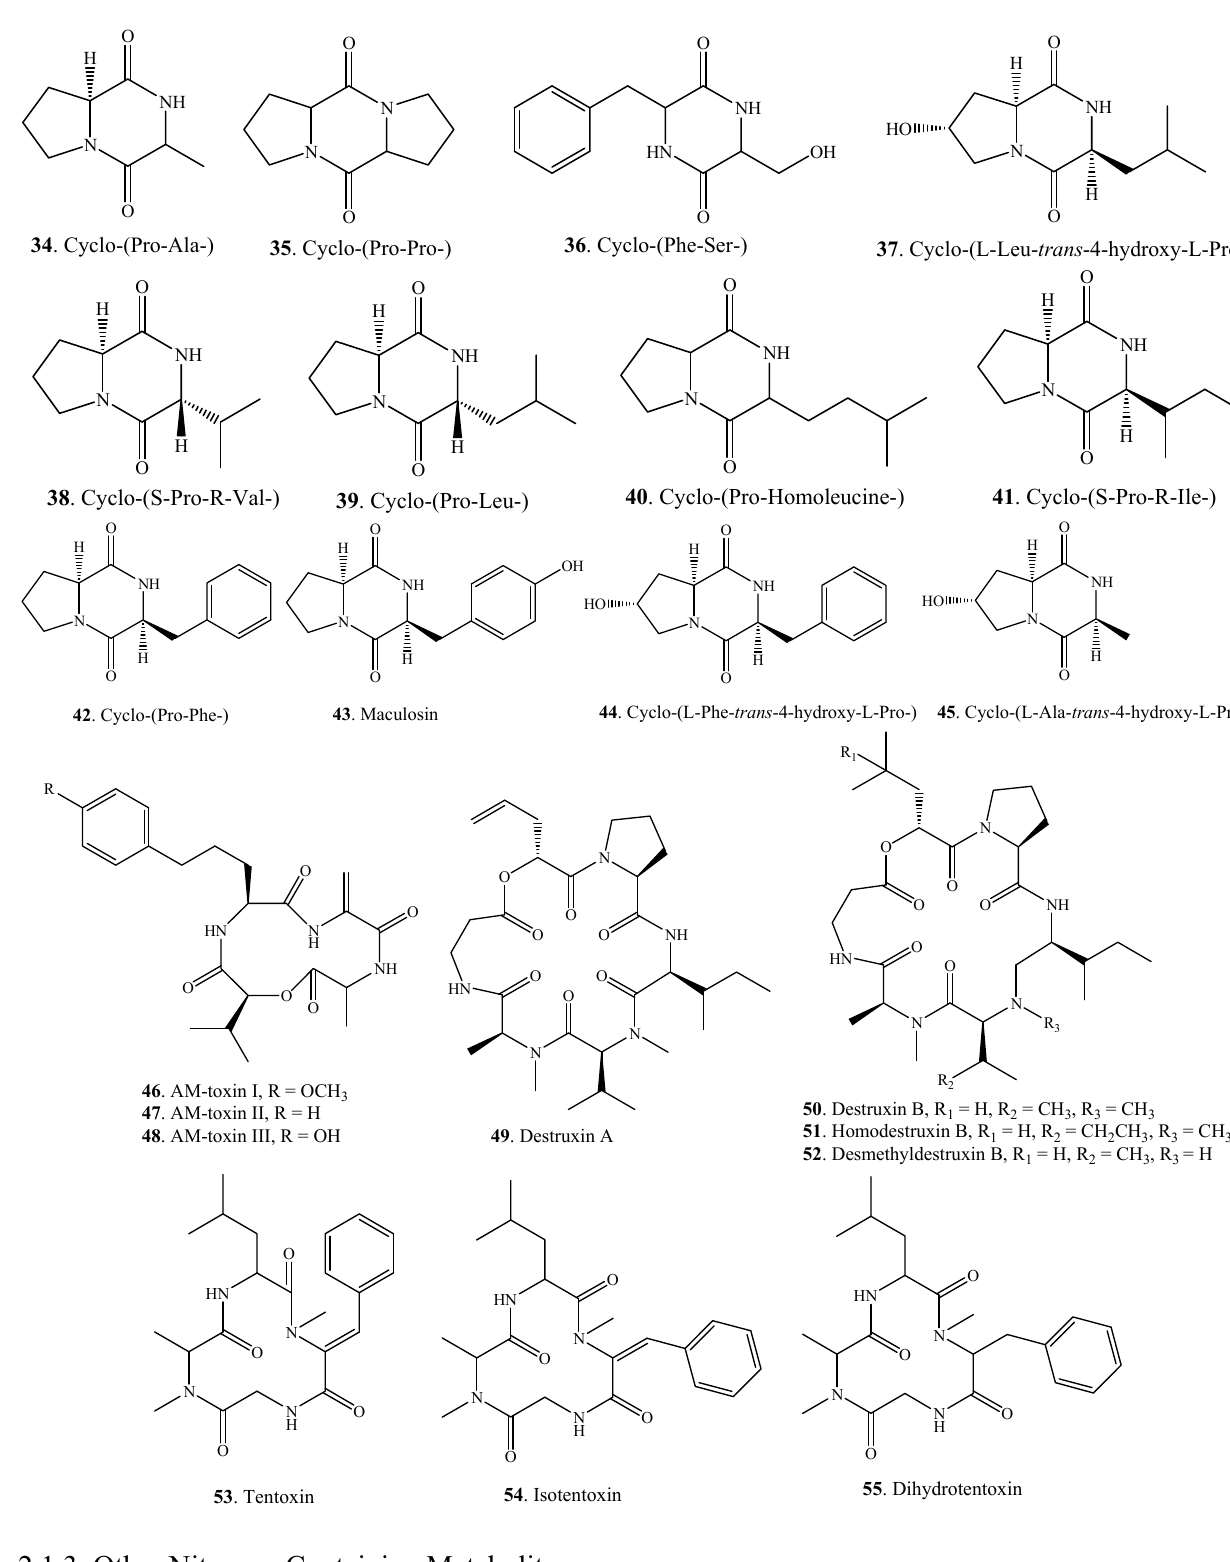
Figure 2. Cyclopeptides isolated from Alternaria